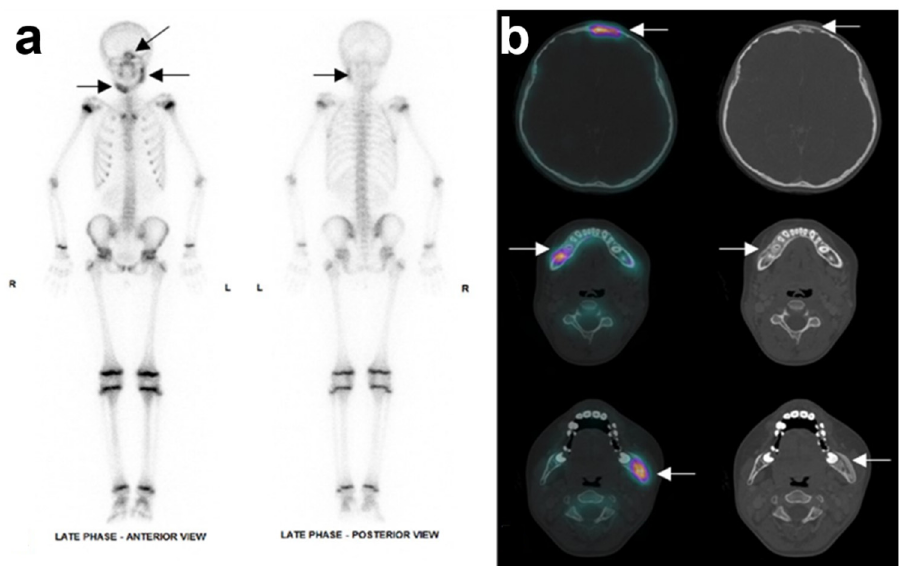
Figure 3. Nuclear X-ray of the patient’s initial state: ( a ) Whole-body bone scintigraphy showed three areas of increased uptake (hot spot) in the facial skeleton: in the body of the right mandible, in the angle and ascending ramus of the left mandible, and in right frontal sinus. ( b ) SPECT registered with CT scan displaying, from top to bottom line, the increased uptake in frontal sinus, right and left mandible, respectively. SPECT: single photon emission computed tomography.